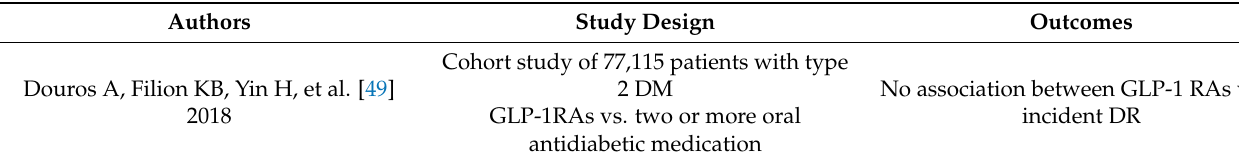
Table 2. Clinical trials assessing the effects of GLP-1 RAs on